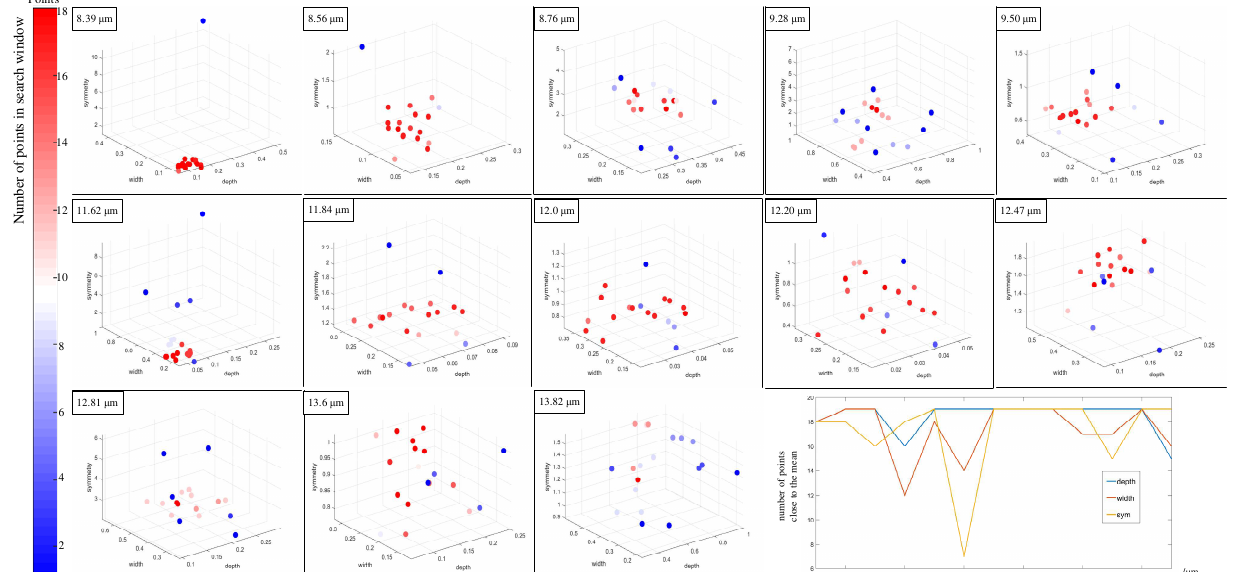
Figure 9. Distribution of each spectral feature with 19 monzonite spectra in customised space, which is described by three quantitative parameters (i.e., relative depth, width and symmetry). In other words, each point in customized space represents the array of parameters (relative depth, width and symmetry) of the emission feature of the related sample. The curves in the bottom left panel represent the number of points close to the mean in individual dimension of the parameters in all spectral features. Table 2. Eigenvalues and cumulative variance of the correlation matrix Component